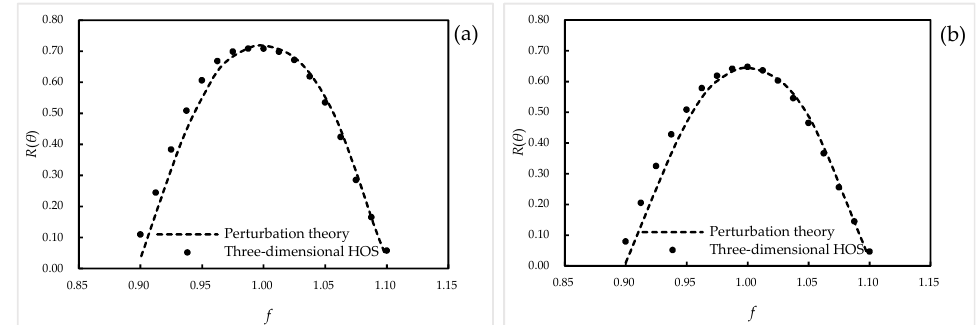
Figure 3. Bragg resonance reflection coefficients of regular waves under different wavenumber ratios f : ( a ) Forward incident condition ( θ =0°); ( b ) Oblique incident condition ( θ =19.5°).